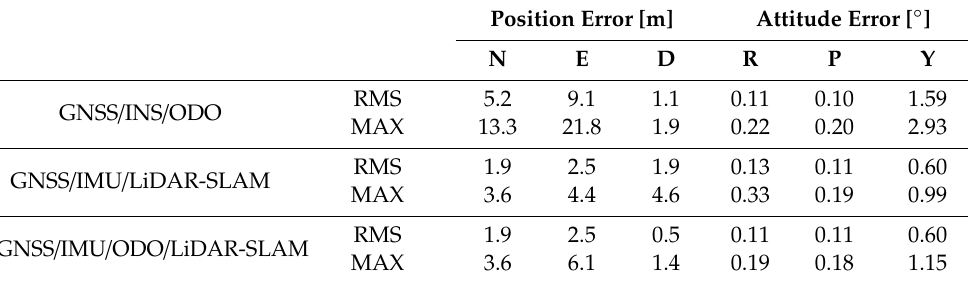
Table 2. Statistical analysis of the open-sky tests with 2 min GNSS